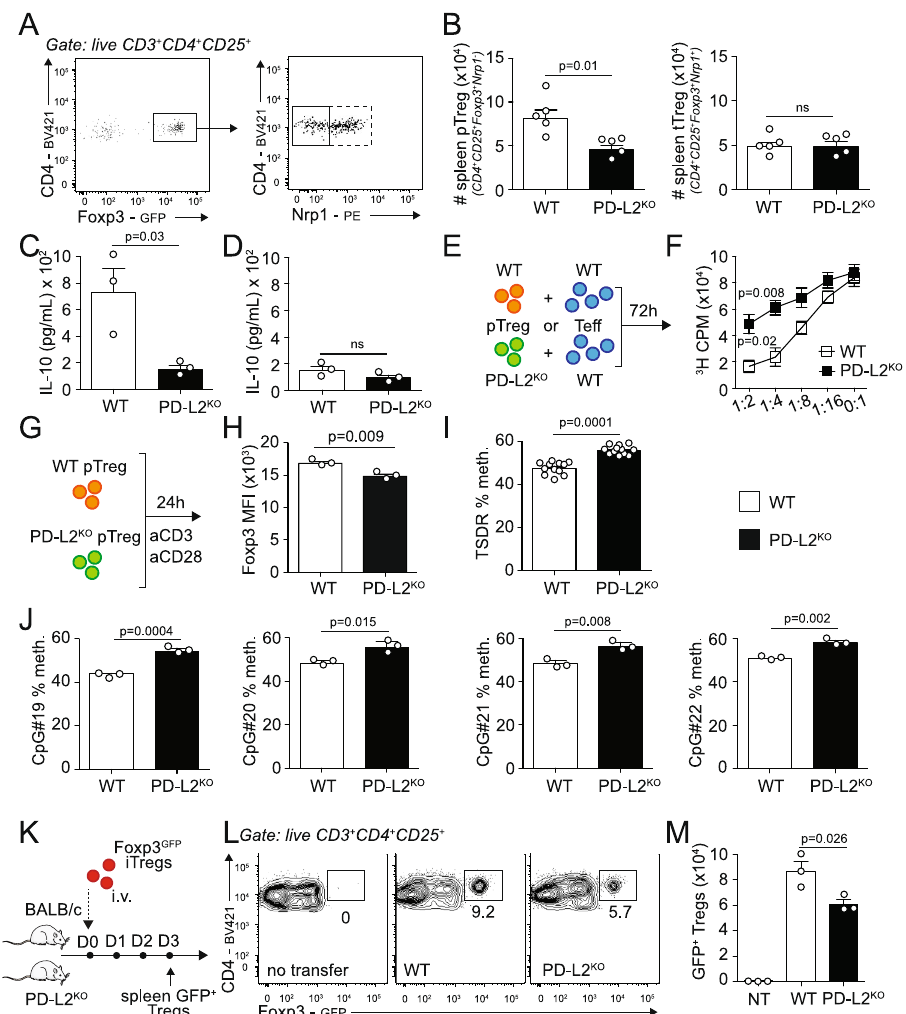
Fig.4|PD-L2regulatespTregnumbers,function,andFoxp3stability.A Spleens of Foxp3 GFP and PD-L2 KO Foxp3 GFP mice were collected and analyzed by fl ow cyto- metry. Representative plots of CD3 + CD4 + CD25 + Foxp3 GFP+ Nrp1 − pTregs and CD3 + CD4 + CD25 + Foxp3 GFP+ Nrp1 + tTregs. B